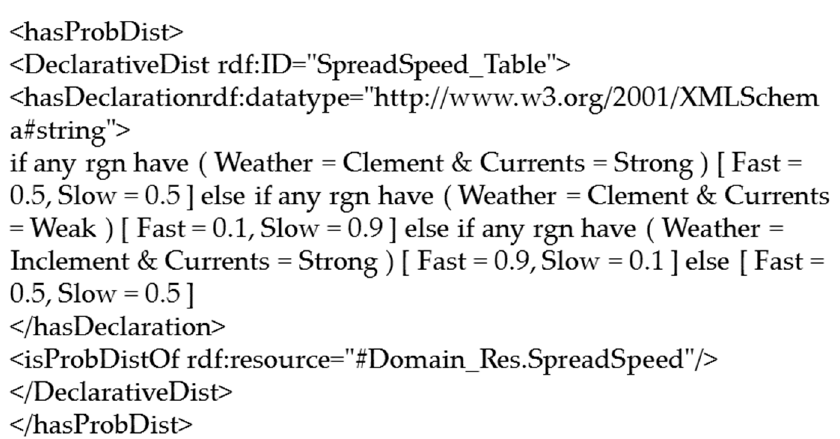
Figure 7. The local probability distribution of SpreadSpeed.